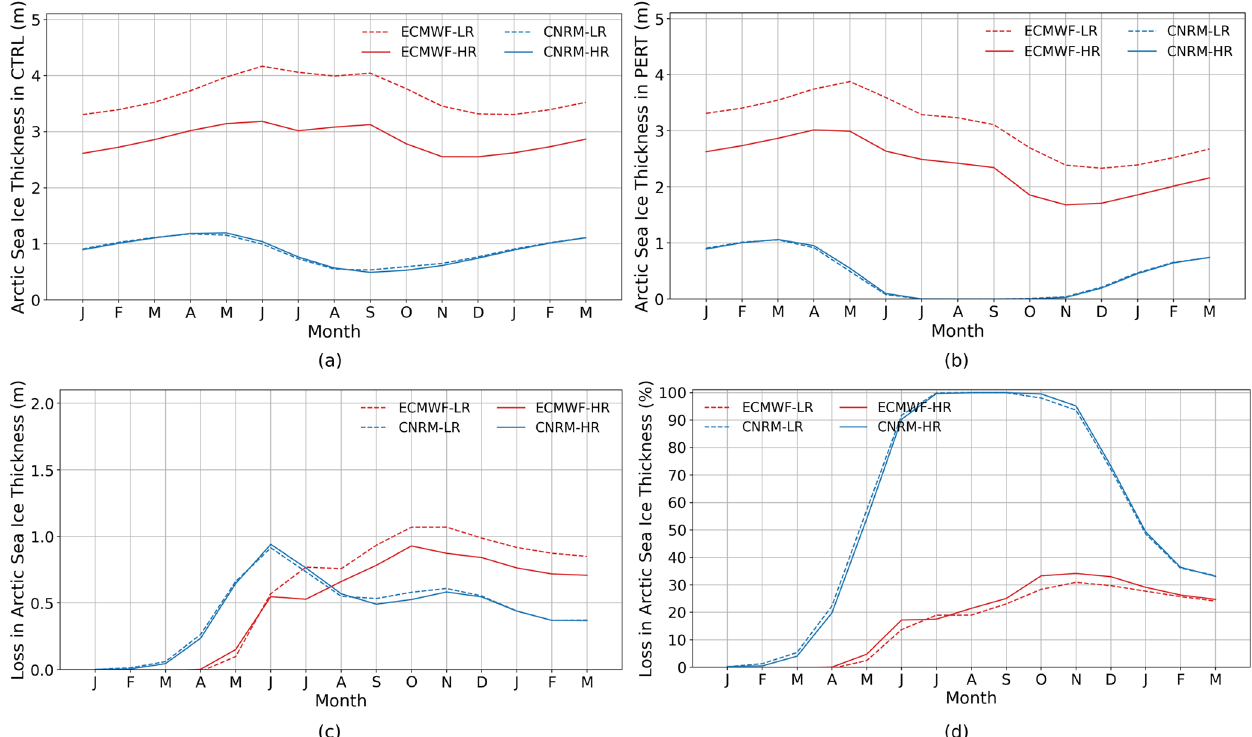
Figure A1. Arctic sea ice thickness (in meters) in CTRL (a) and in PERT (b) . Panels (c) and (d) show the decrease in Arctic sea ice extent in PERT compared to CTRL (i.e. CTRL − PERT) in meters and in percent relative to the CTRL value,